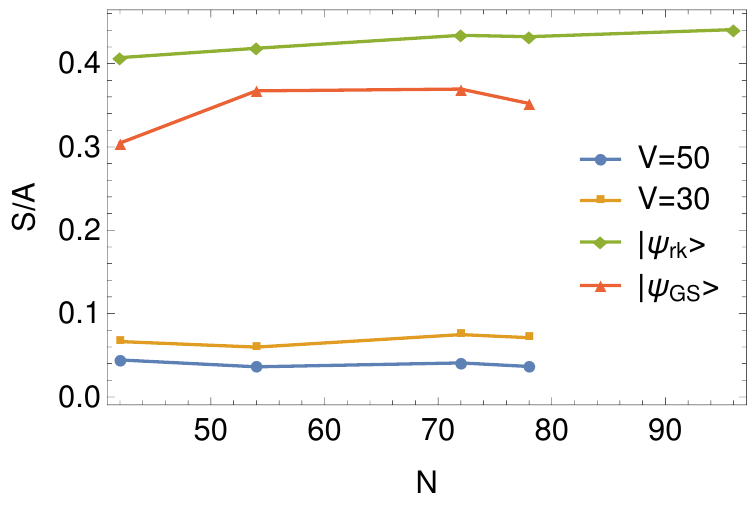
Figure 16: Bipartite entanglement entropy of some reference states in the honey- comb lattice rescaled by the size of the boundary between the two subsystems, S / A , showing an area law scaling. Shown are entanglement scalings for the ground state | ψ 〉 of the non-disordered model with constant field V GS | ψ 〉 , and the localized states at disorder V = 30 and V = RK